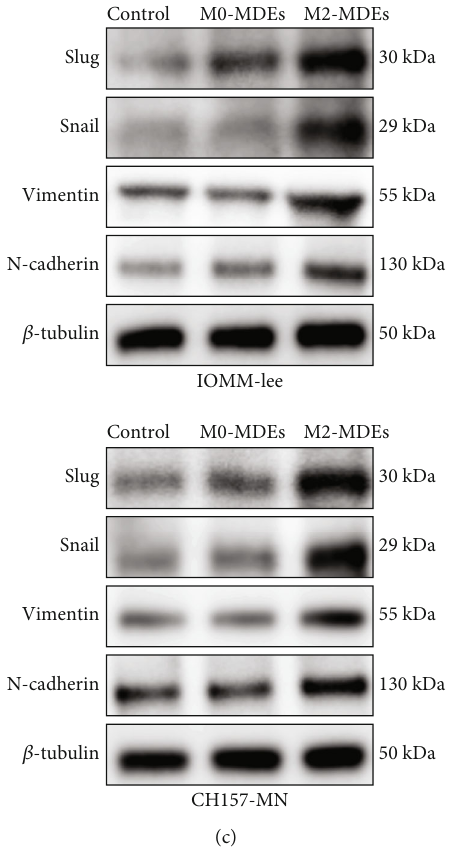
Figure 3: M2-MDEs promote the migration and invasion of meningioma cells. (a) The wound healing assay was used to examine the mobility of IOMM-Lee and CH157-MN cells. Scale bars 200 μ m. (b) The migration and invasion ability of IOMM-Lee and CH157-MN cells was assessed using Transwell chambers, and the number of cells passing through the upper chamber membrane was counted. Scale bars 100 μ m. (c) Protein expression levels of slug, snail, vimentin, and N-cadherin were detected by western blotting. ∗ p < 0 : 05 , ∗∗ p < 0 : 01 , ∗∗∗ p < 0 : 001 , vs. the control and M0-MDE